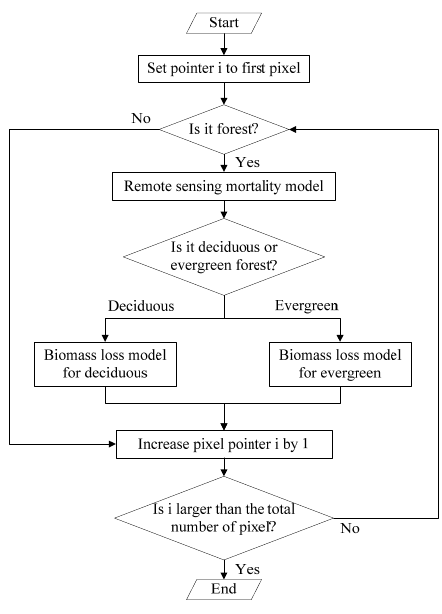
Figure 5. The Monte Carlo simulation routine for estimating biomass loss.